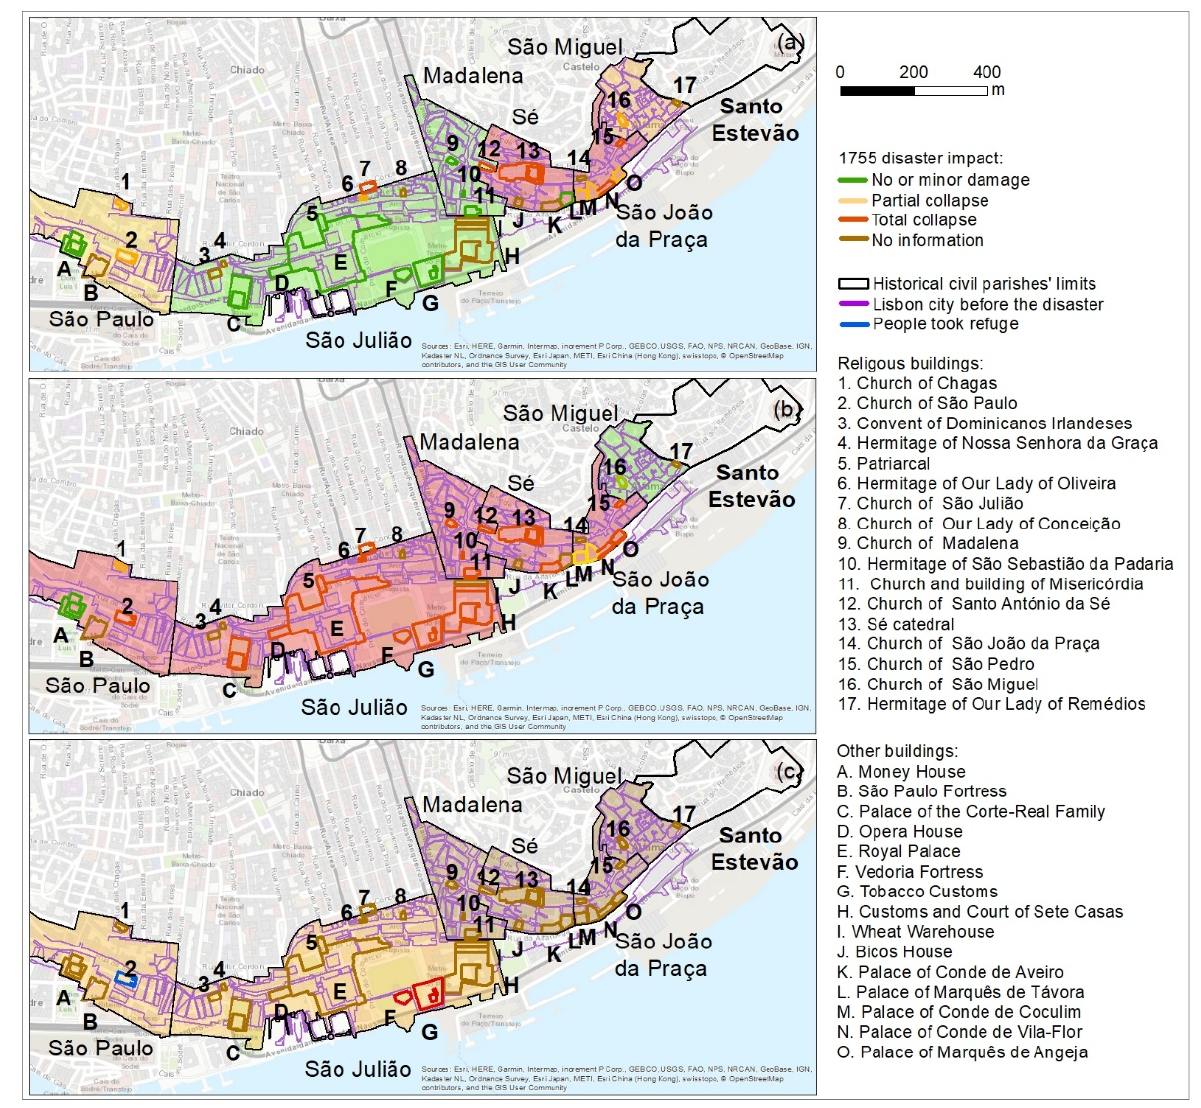
Figure 2. Impact of the 1755 disaster on the historical civil parishes of downtown Lisbon (adapted from [44]) due to: ( a ) earthquake; ( b ) fire; ( c ) tsunami. The present-day layout of the city is presented on the background. This study is focused mainly on Santo Estevão.